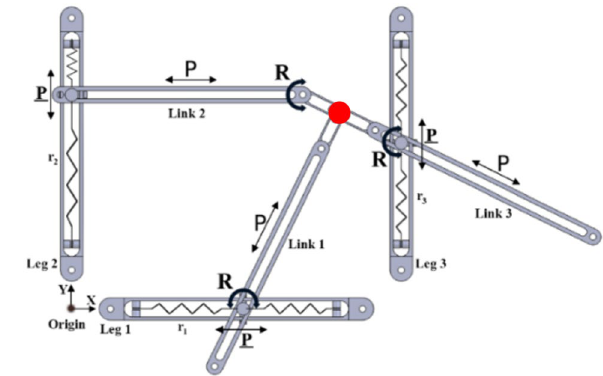
Fig. 15 C8 manipulator